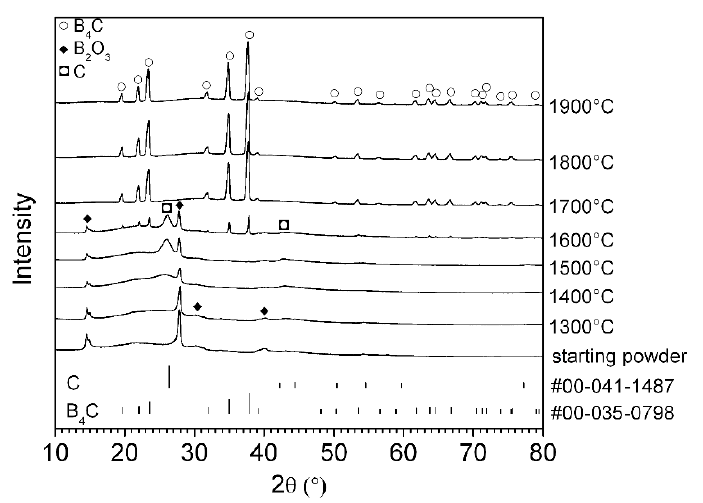
Figure 3. XRD patterns of starting powder and products prepared at 1300–1900 °C for 20 min from mixture with a molar ratio of B 2 O 3 /C = 0.75:1, powder diffraction file number: 00-041-1487 (graphite) and 00-035-0798 (B 4